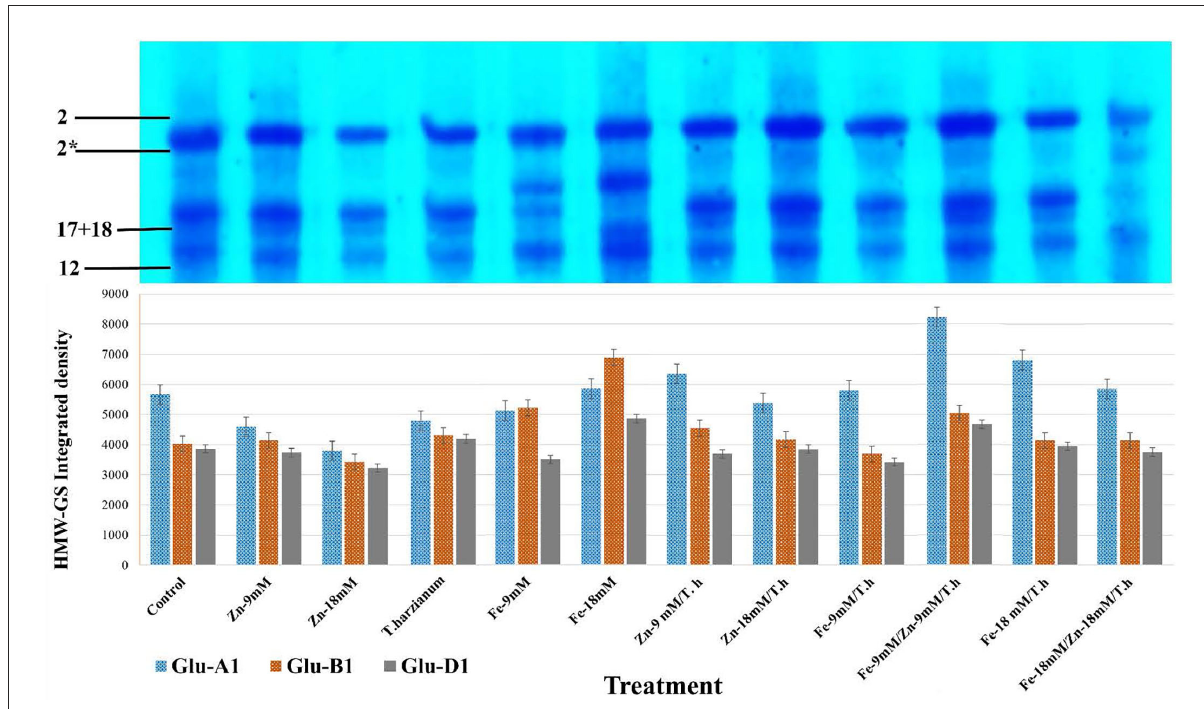
FIGURE3 SDS-PAGE profile of HMW-GS alleles of the studied wheat cultivar and its area integrated densities under different treatments. For accuracy and validity of data, the average area integrated densities were determined for comparison. HMW-GS 2* asterisk.